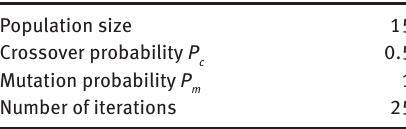
Table 3: GA Parameters.